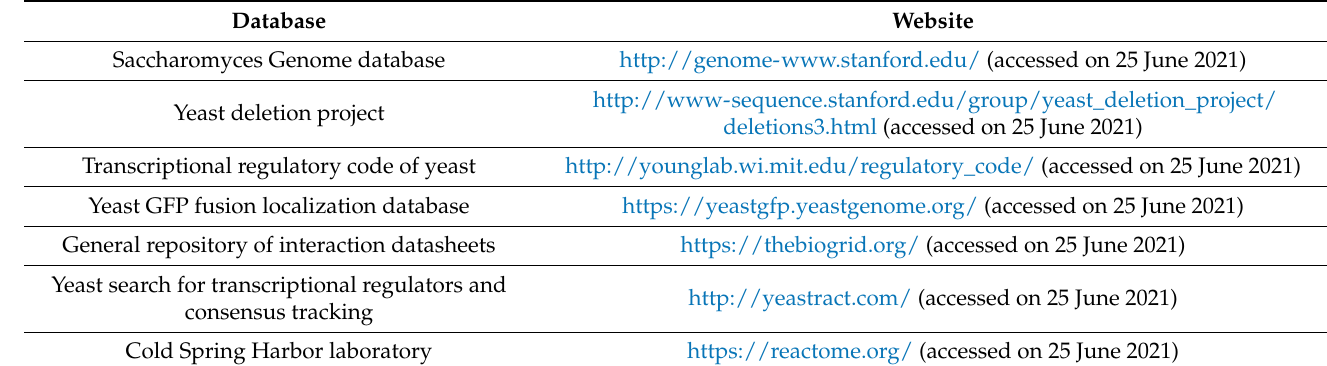
Table 1. Yeast-related online databases and their web